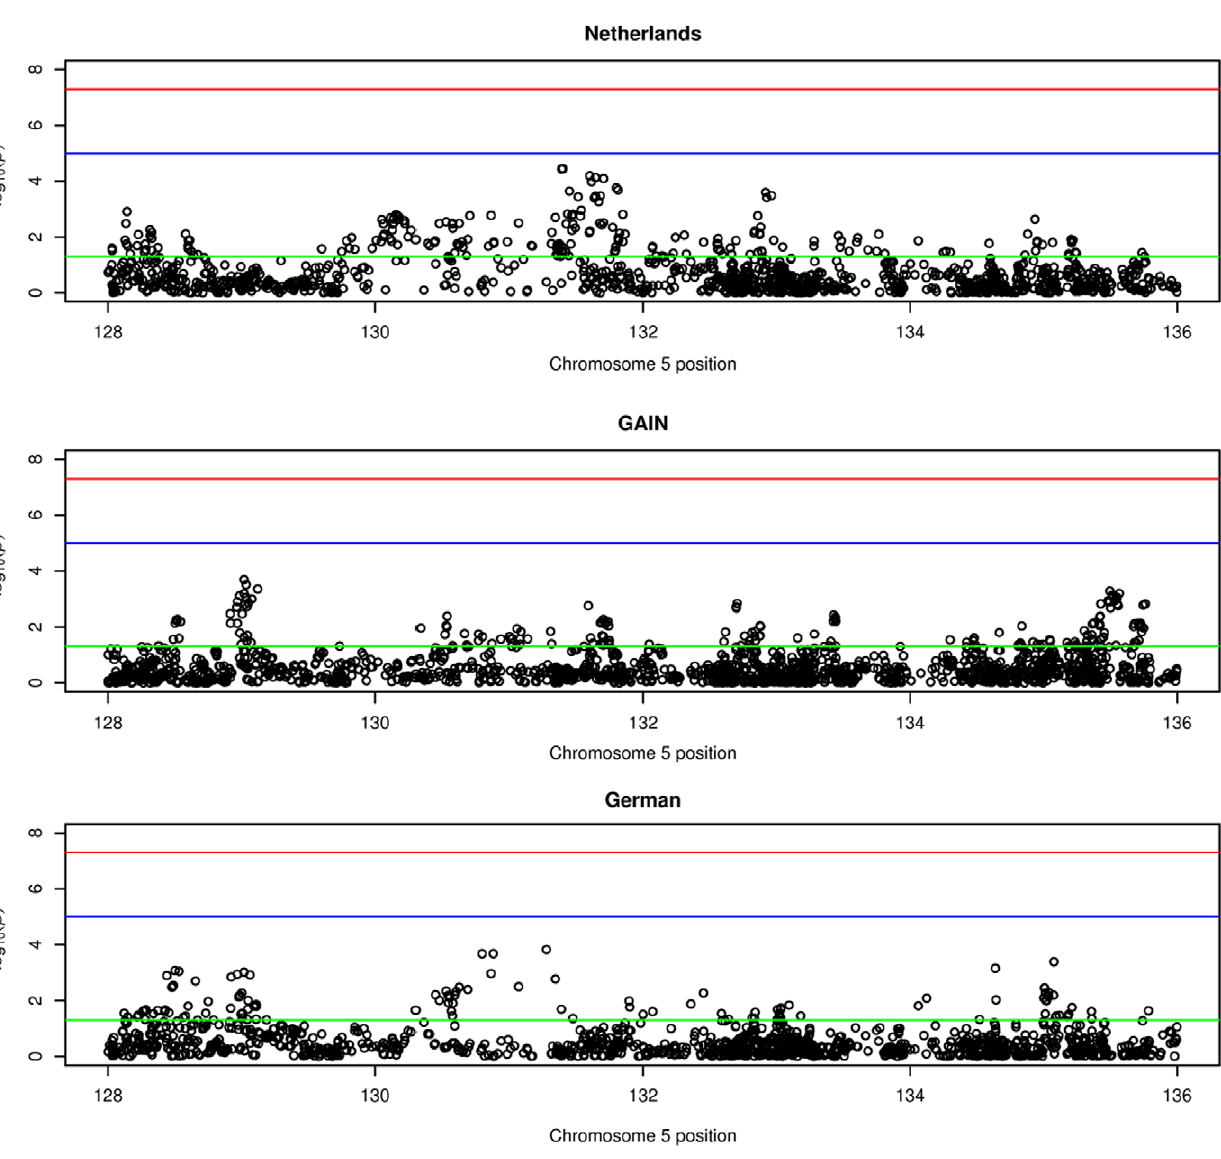
Figure 2. ‘‘Manhattan plot of the top segment located at chromosome 5 (128–136 Mbp)’’. This figure shows at the y–axis the p-values of the SNPs located at chromosome 5 (128–136 Mbp). The chromosomes are shown at the x-axis. The red line indicates a p-value of 10-7, the blue line indicates a p-value of 10-5 and the green line indicates a p-value of .05.